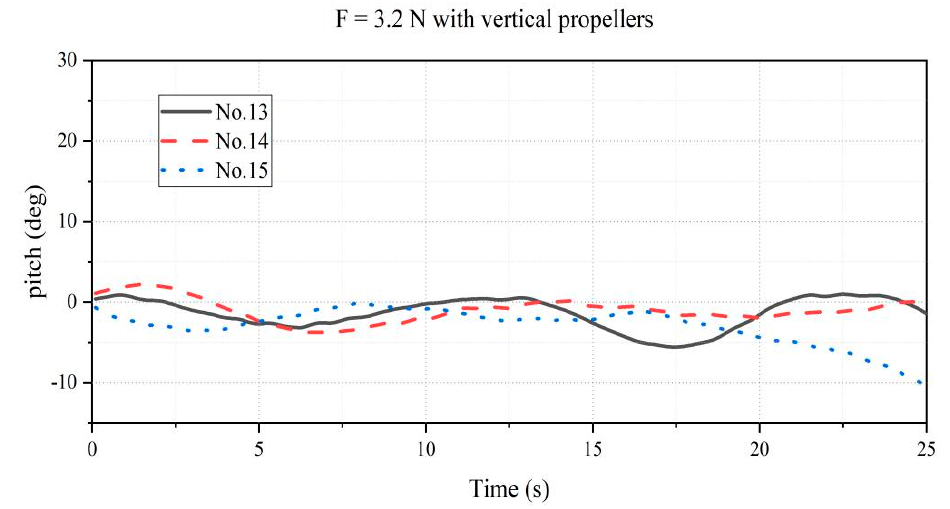
Figure 12. The pitch angle of horizontal motion experiments when F is 3.2 N with vertical propellers.